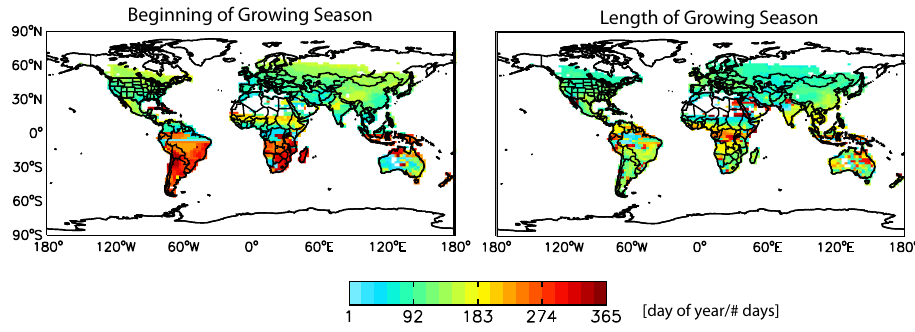
Fig. 4. Beginning of the growing season (day of year) and growing season length (# days) determined using MODIS enhanced vegetation index as described in the text. Boxes with no chemical fertilizer application are colored